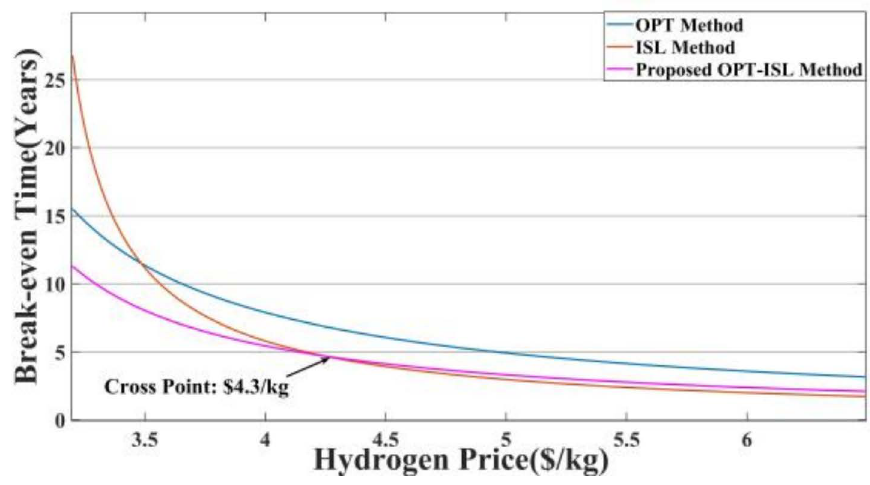
Figure 12. Break-even time with different hydrogen